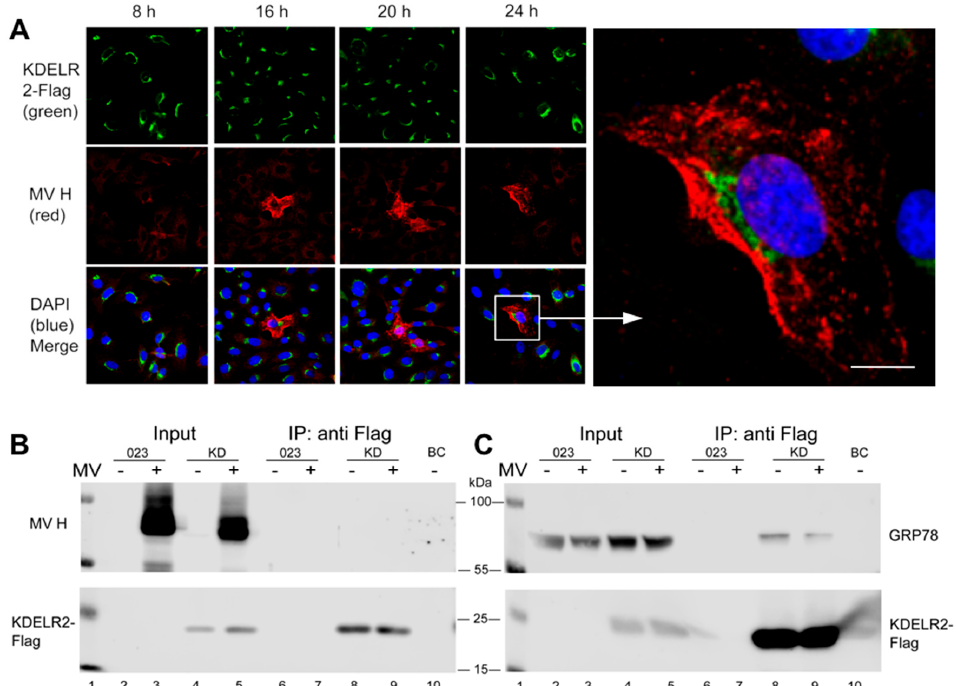
Figure 4. No detectable interaction was seen between KDELR2 and MV-H, but of KDELR2 with GRP78. ( A ) Transduced Vero cells over-expressing the KDELR2 (Vero-KDELR2-Flag) were infected with MV (MV-Edmonston not expressing eGFP) at a MOI of 0.1. After 8, 16, 20, and 24 h, cells were fixed and stained with antibodies to Flag and Alexa-488-conjugated secondary antibodies (green), to MV-H and Alexa-594-conjugated secondary antibodies (red), and DAPI (blue). Photomicrographs were taken using a confocal microscope (enlargement 400×; size bar = 20 µm). For co-immunoprecipitations, lysates of MV-infected and uninfected (as indicated) Vero-023 and Vero-KDELR2-Flag (KD) cells remained untreated (input, lanes 2 to 5) or were treated with anti-Flag antibody-conjugated beads for precipitation (IP: anti-Flag, lanes 6 to 9). Control precipitation was with unconjugated beads (BC, lane 10). Proteins were size separated by 10% SDS-PAGE, blotted onto nitrocellulose, and in ( B ) detected with antibodies to MV-H (polyclonal rabbit H45, upper panel), or to Flag detecting KDELR2 and secondary antibodies as indicated (lower panel). In ( C ), Western blots were treated with antibodies to GRP78 (upper panel), or to Flag detecting KDELR2 and secondary antibodies as indicated (lower panel).